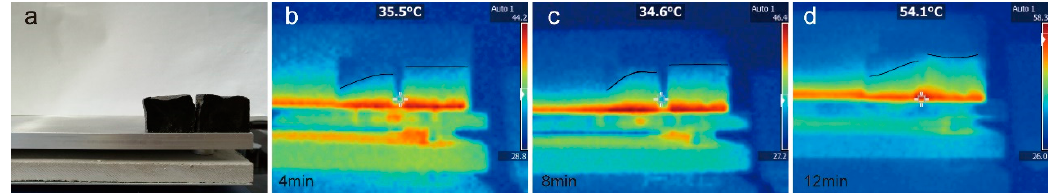
Figure 17. Thermal imaging images of *PC12W0E0 (left) and PC12W5E15 (right). ( a ) was the digital image taken before heating; ( b ), ( c ) and ( d ) were the thermal imaging images taken at 4 min, 8 min and 12min respectively.